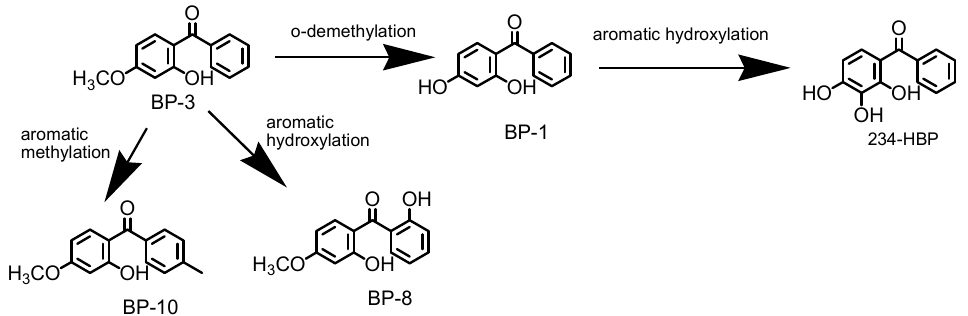
Figure 5. BP-3 metabolization pathway in fish organs.